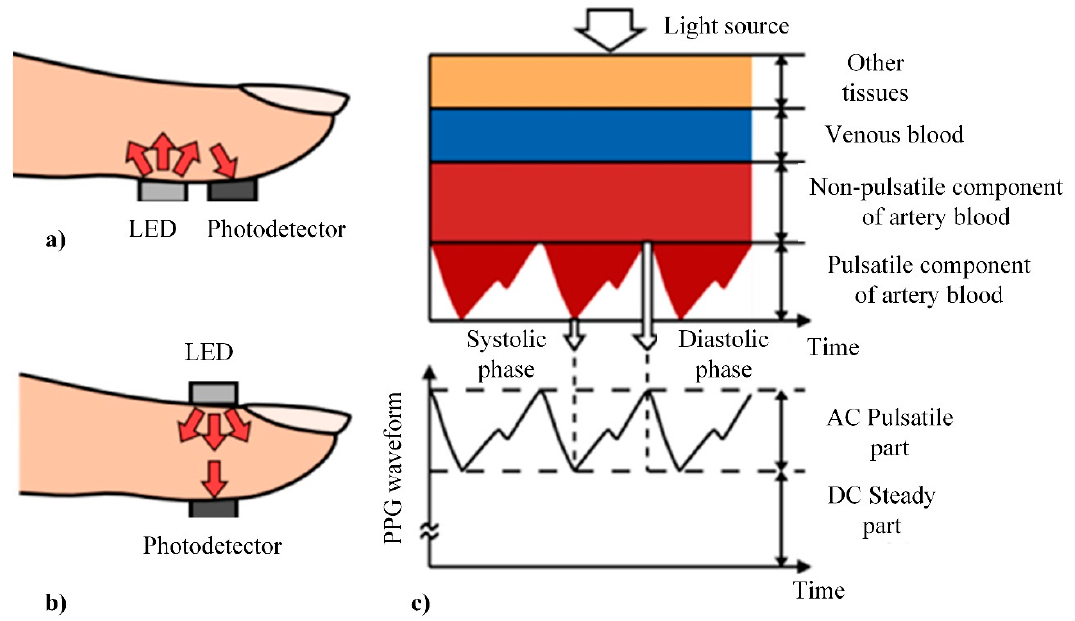
Figure 8. Principle of photoplethysmography (PPG) [104]: ( a ) reflective mode; ( b ) transmitting mode; ( c ) example of PPG signal.